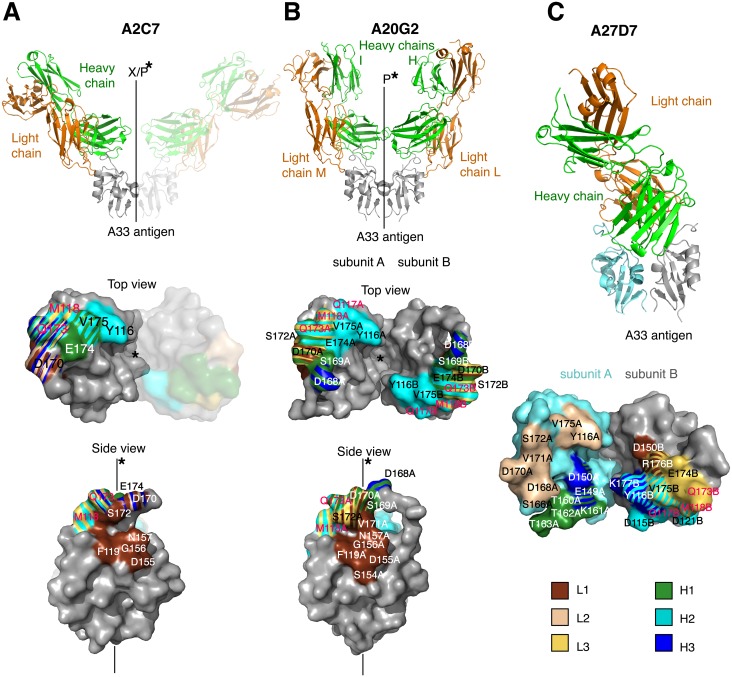
Structures of A33/A2C7, A20G2, and A27D7-Fab complexes.Structures of (A) A33/A2C7, (B) A20G2, and (C) A27D7-Fab complexes. Structures are shown as cartoon representations, with light chains in green and heavy chains in orange (top), while the antibody footprints on the molecular surface of A33 are shown below. In (C), A33 subunits (SUs) are shown in different colors because the epitope spreads asymmetrically over both SUs (SU A in aquamarine, SU B in grey). Footprints on A33 is colored according to contacting CDR loops (L1, brown; L3, yellow; H1, green; H2, cyan; H3, blue). Stripe patterns highlight A33 residues that elicit contacts with more than 1 CDR. The continuous line and the asterisk indicate A33 dimer axis. Letters indicate when this axis constitutes a crystallographic axis (X) along with the A33 dimerization axis (P). A33 residues that are part of the orthopox variation profile are labeled in magenta.